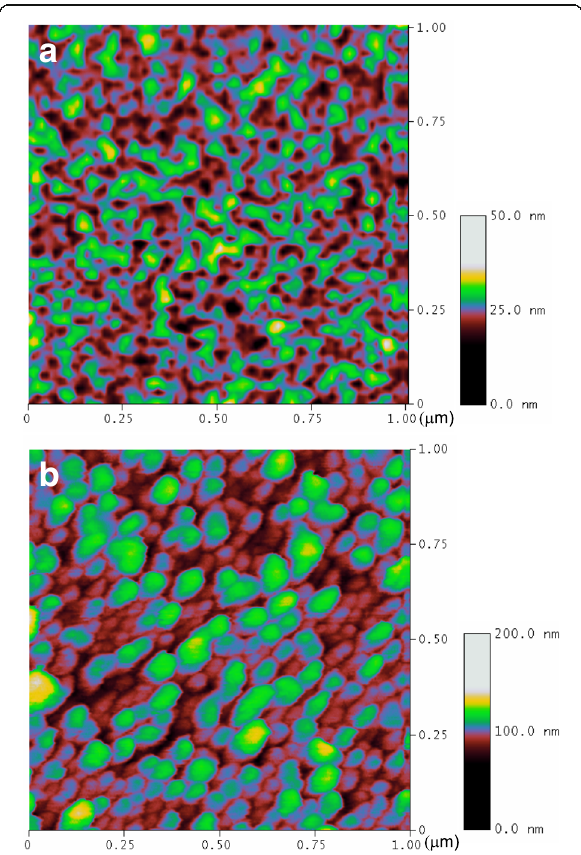
Fig. 2 Topographic images obtained with atomic force microscope (AFM). a AAO template. b Ag nanoparticles array grown in AAO template